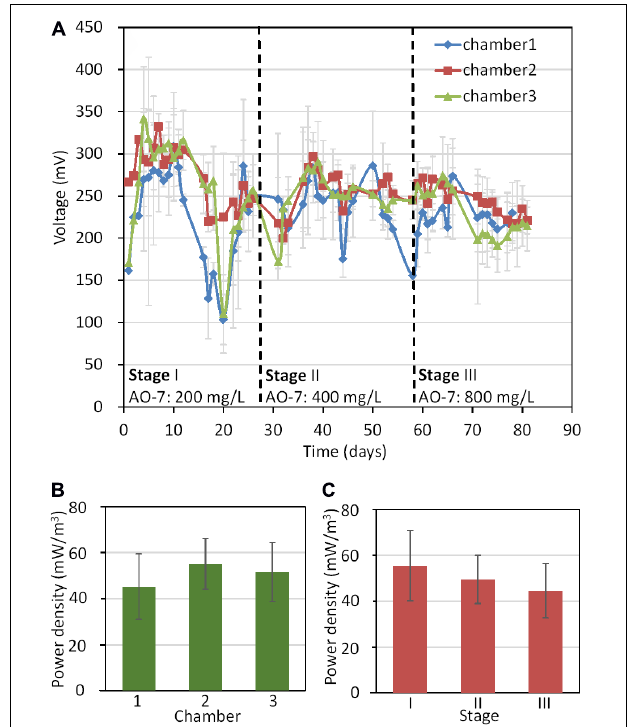
FIGURE 1 | Electricity generation in MFC-ABRs. (A) Voltage curve of the three chambers with different AO-7 concentrations; (B) The average power densities in different chambers; (C) The average power densities in different